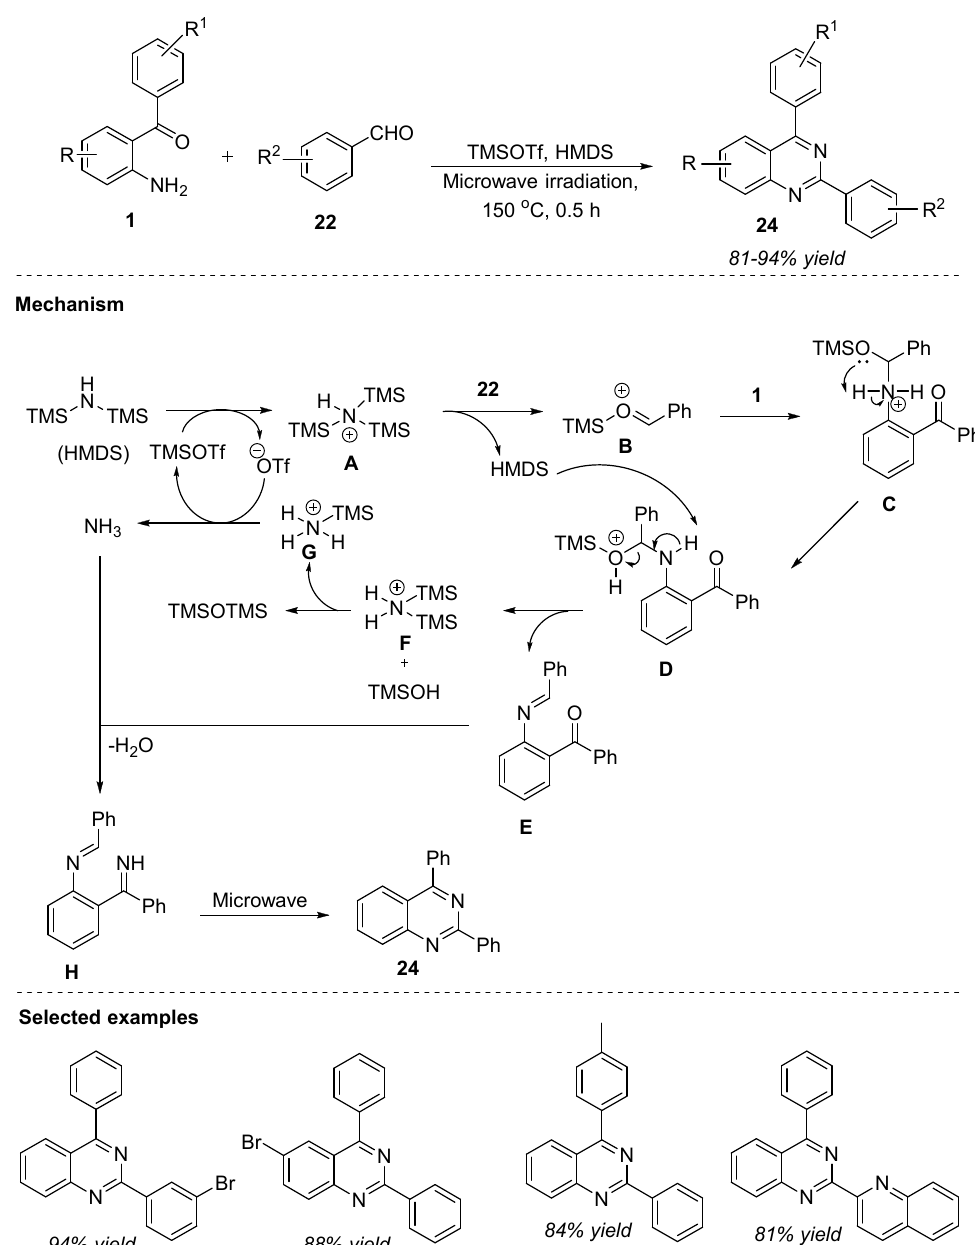
Scheme 11. TMSOTf-HMDS-catalyzed synthesis of quinazolines.